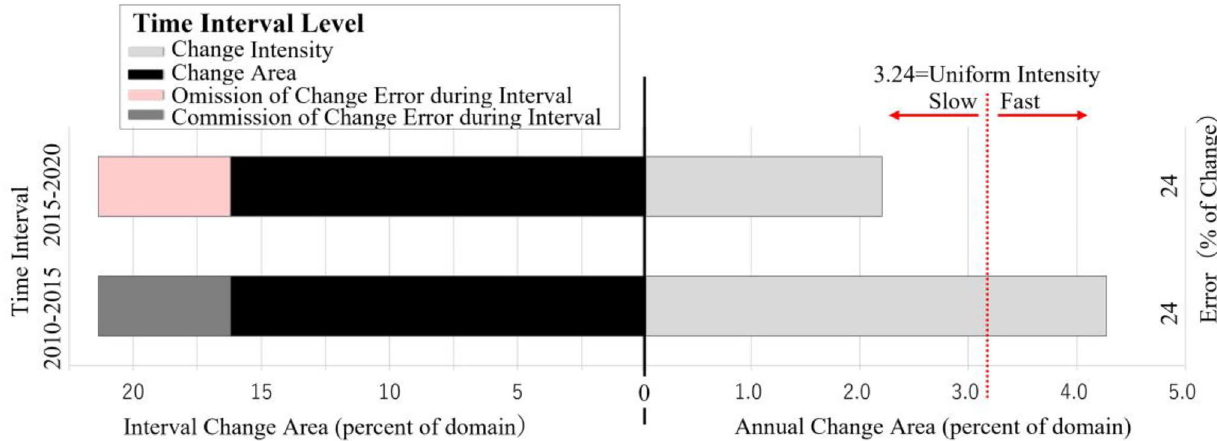
Fig. 7 Interval level intensity